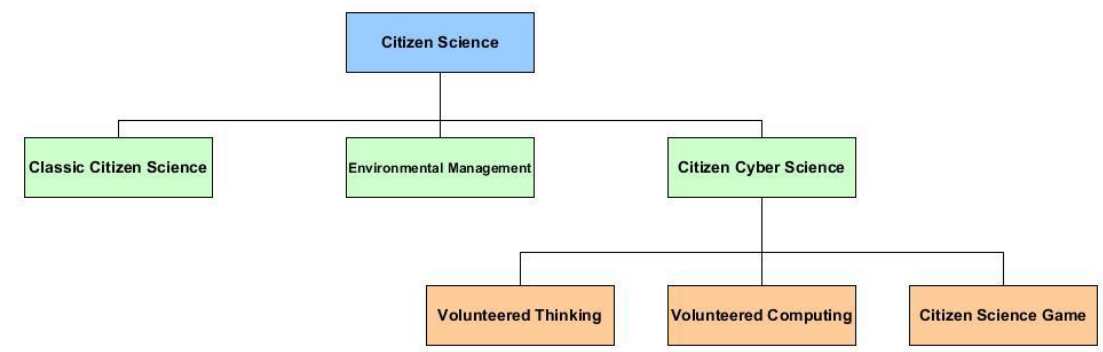
Figure 4. Citizen science typology as defined by Haklay [14], with the di ff erence that for citizen cyber science, participatory sensing is replaced by citizen science game, as suggested by Curtis